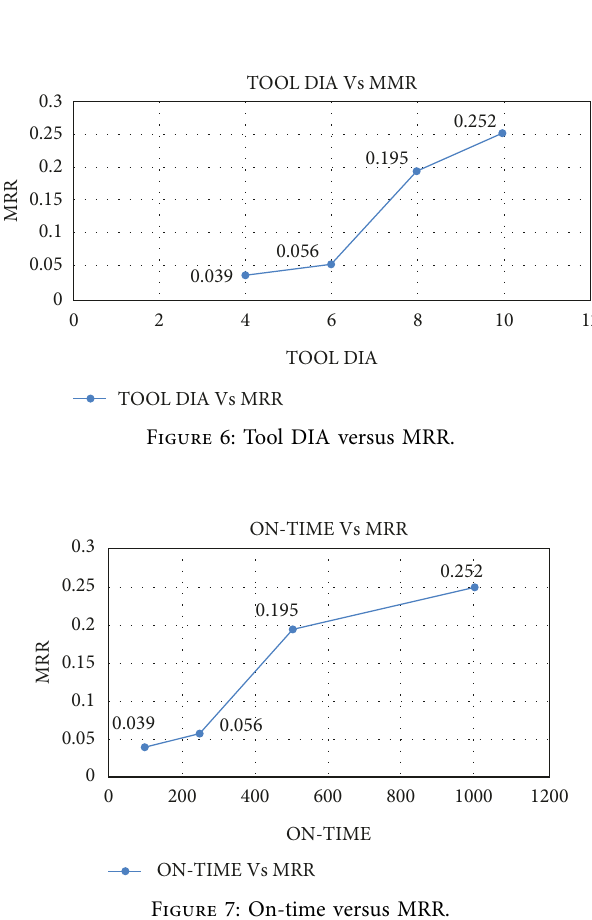
Figure 8: Current versus TWR.